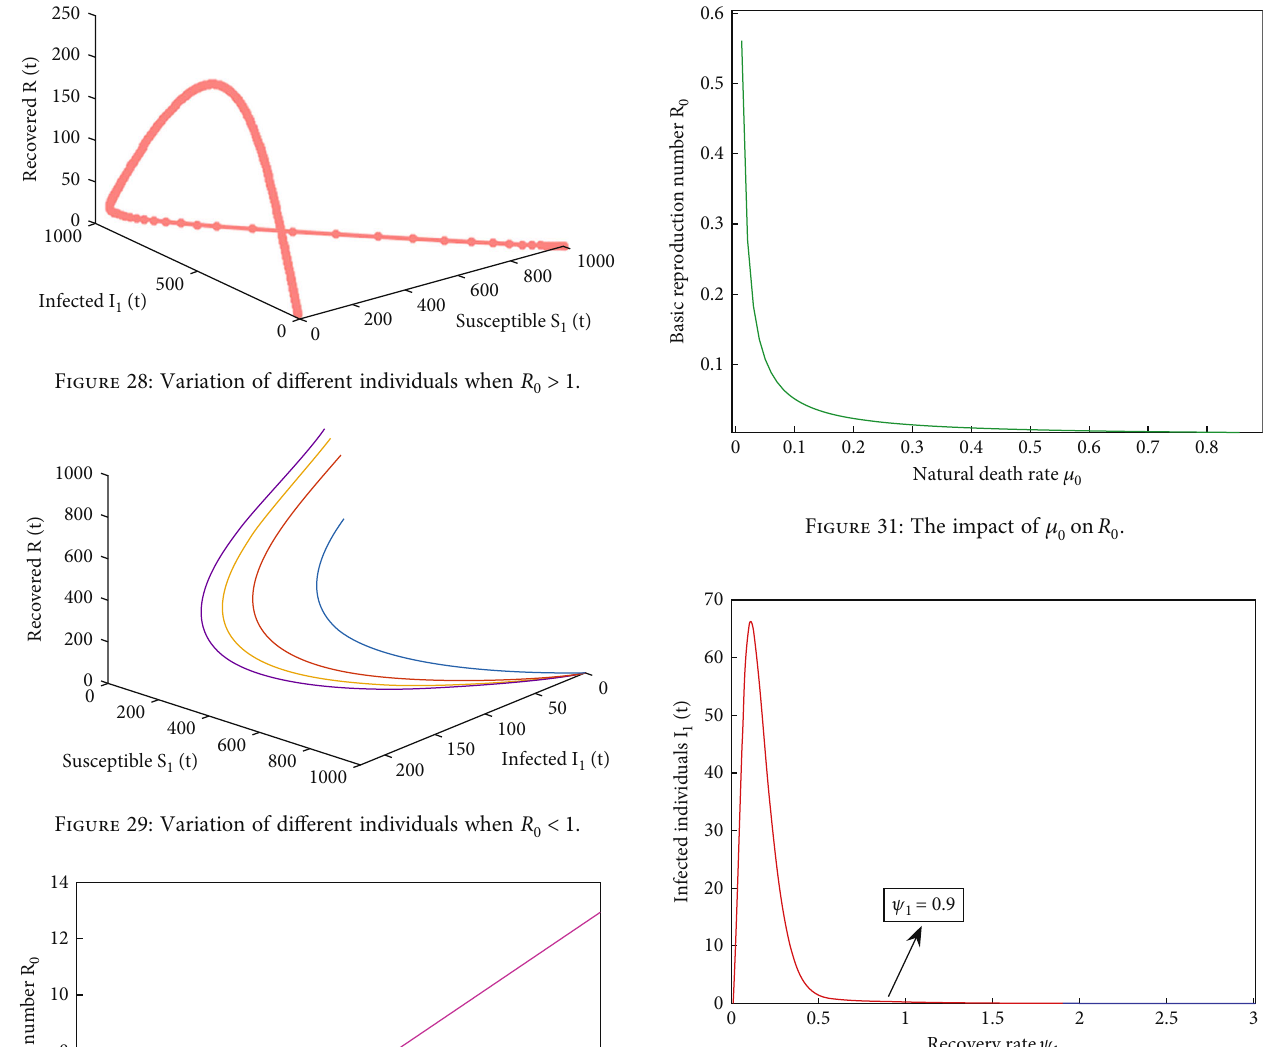
Figure 32: For Transcritical bifurcating parameters ψ diagram with respect to infected